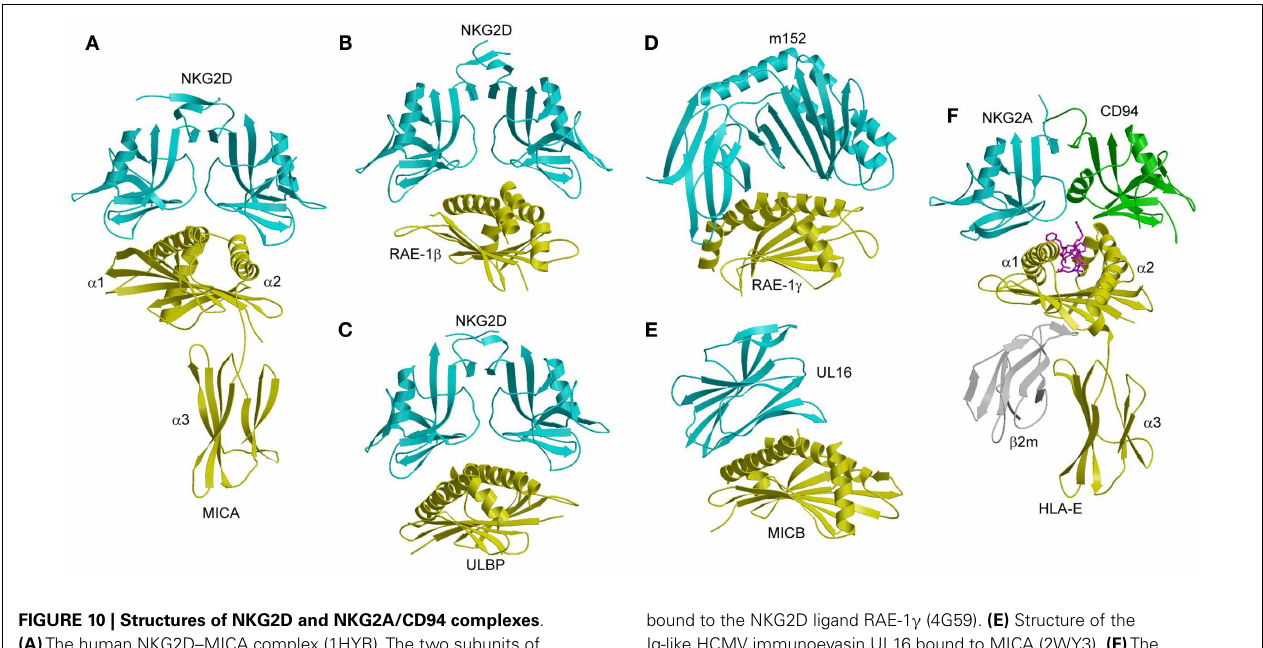
FIGURE 10 | Structures of NKG2D and NKG2A/CD94 complexes . (A) The human NKG2D–MICA complex (1HYR).The two subunits of the NKG2D homodimer are cyan; MICA is yellow. (B) The mouse NKG2D–RAE-1 β complex (1JSK). (C) The human NKG2D–ULBP3 complex (1KCG). (D) Structure of the MCMV immunoevasin m152